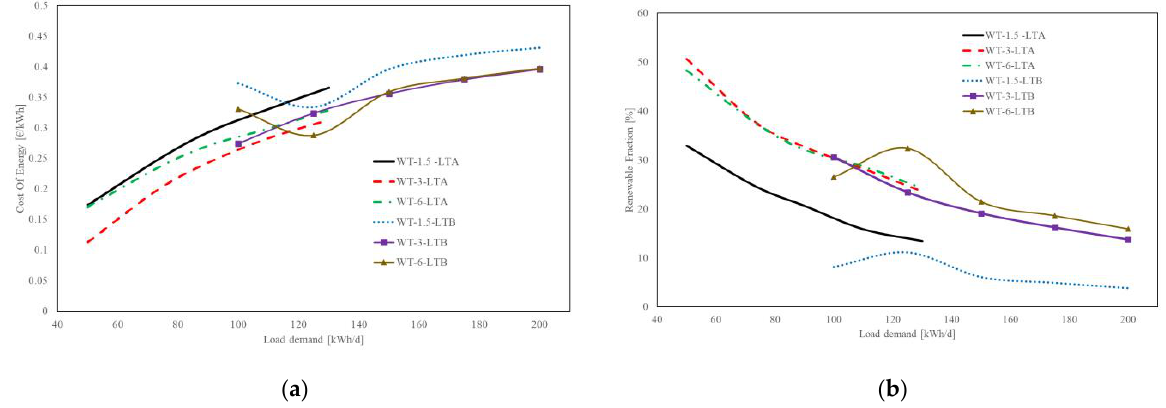
Figure 11. Load demand parametric study for the default wind pattern for different wind turbines. ( a ) COE vs. load demand; ( b ) Ren.Fr. vs. load demand.